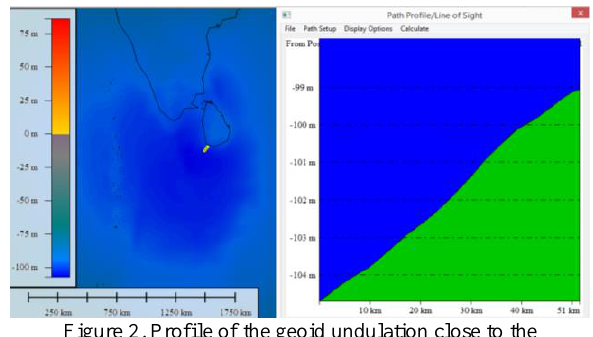
Figure 2. Profile of the geoid undulation close to the Sri Lanka coast